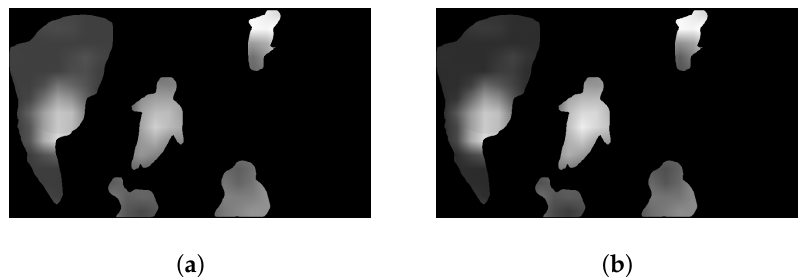
Figure 9. ( a ) The initial attention map with the identical weights; ( b ) The initial attention map with the gradient variation based